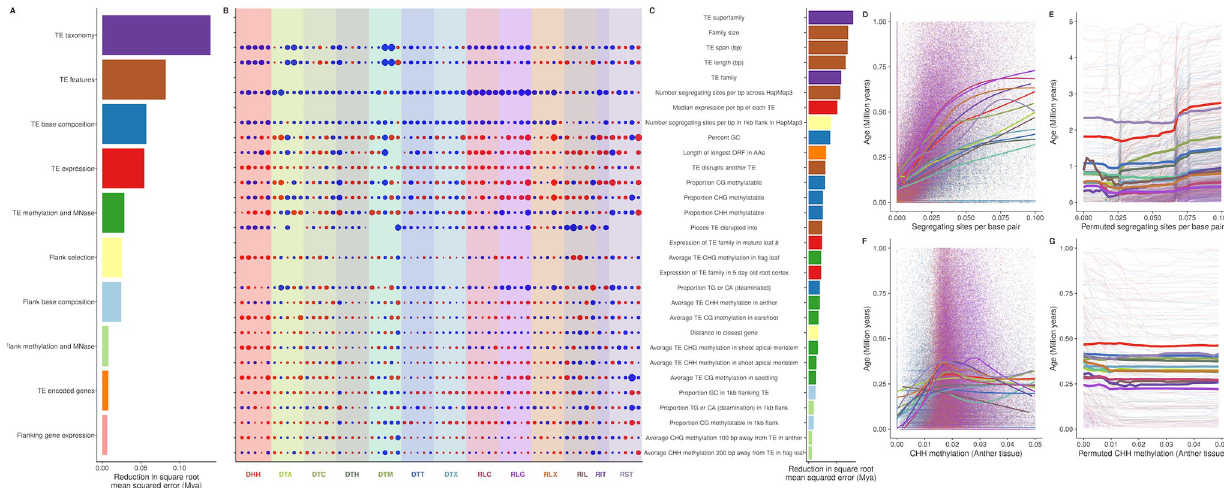
Fig 7. Features ranked by importance. (A) Reduction in mean squared error gained by including a feature in a model, summarized into categories. (B) Correlations of each of the top 30 features with age for the five largest families in each superfamily. Features labeled to the right in (C). Size of point is scaled by correlation coefficient, and color by whether the relationship is positive (blue) or negative (red). Rows without values are features that are fixed within a family, thus have no variance. (C) Reduction in mean squared error for top 30 individual features. Colors match categories in (A). (D) Raw correlations between age and segregating sites per base pair (E) Model predictions for the relationship between age and segregating sites per base pair (F) Raw correlations between age and anther CHH methylation of the TE (G) Model predictions for the relationship between age and anther CHH methylation of the